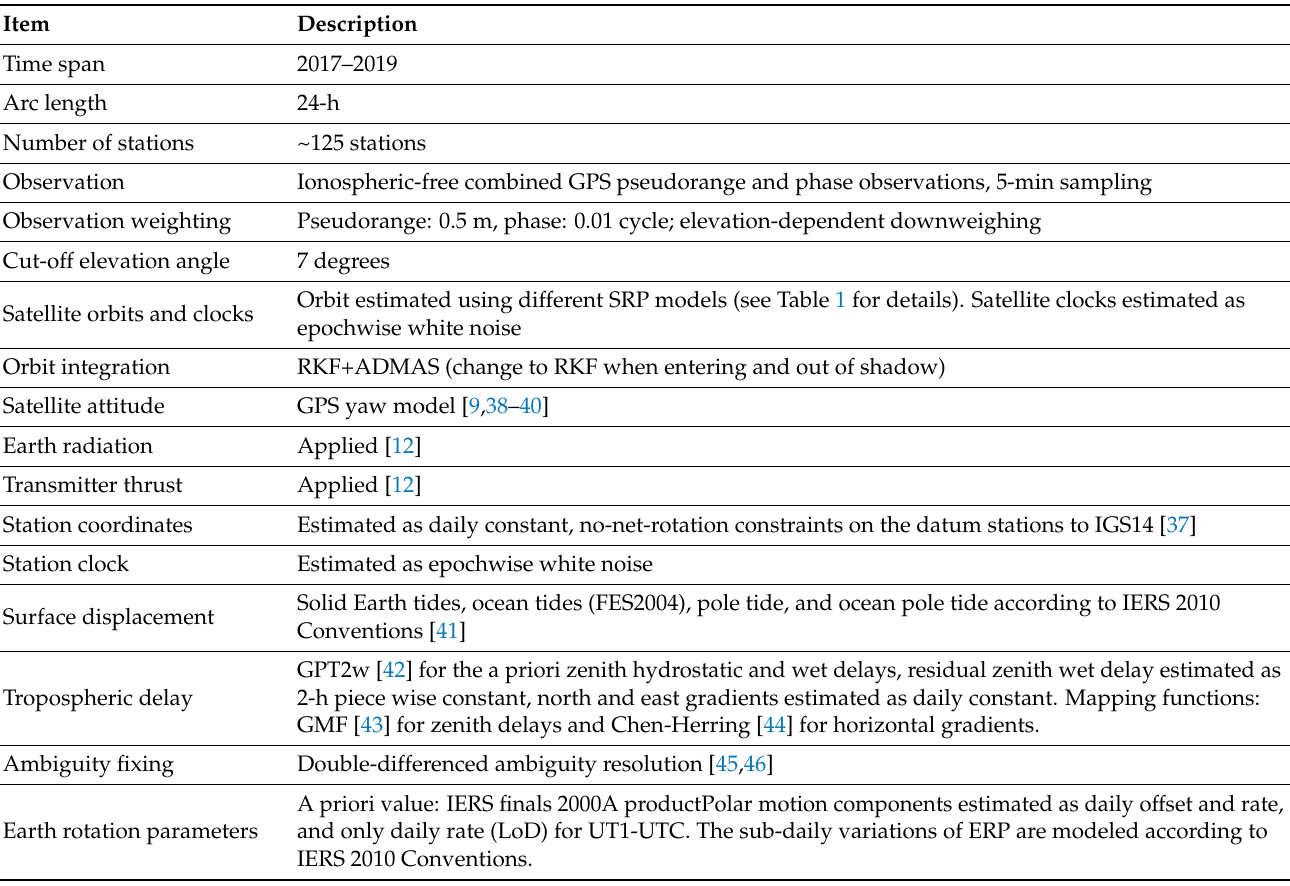
Table 2. Data processing strategy of GPS precise orbit determination